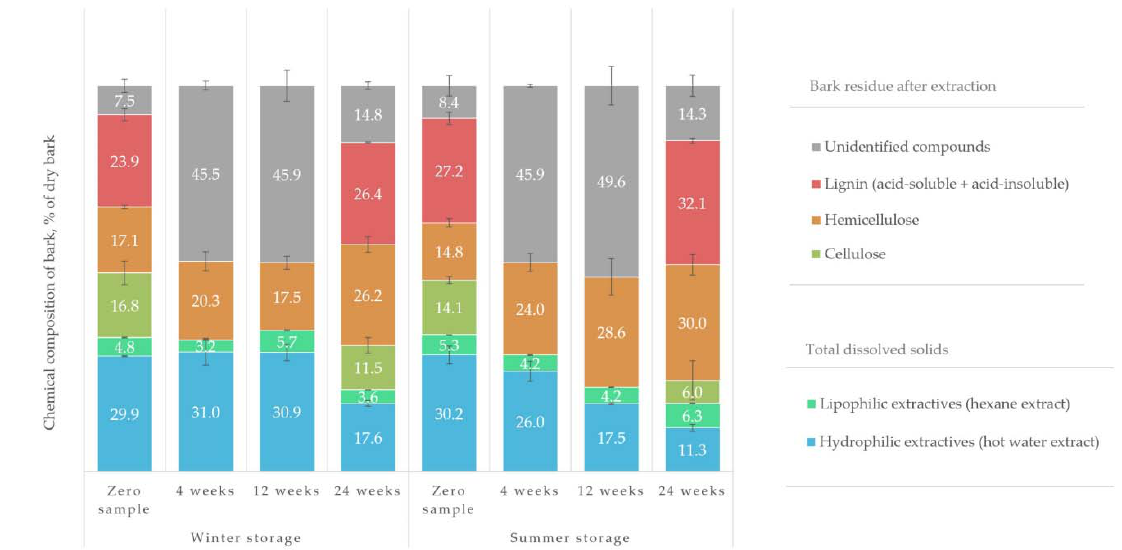
Figure 3. Summary of the overall chemical change in bark samples during the winter and summer storage. Total dissolved solids (both hydrophilic and lipophilic), carbohydrate content (cellulose and hemicelluloses), the amount of lignin and unidentified compounds are shown. The amount of cellulose and lignin was not determined for samples of weeks 4 and 12.